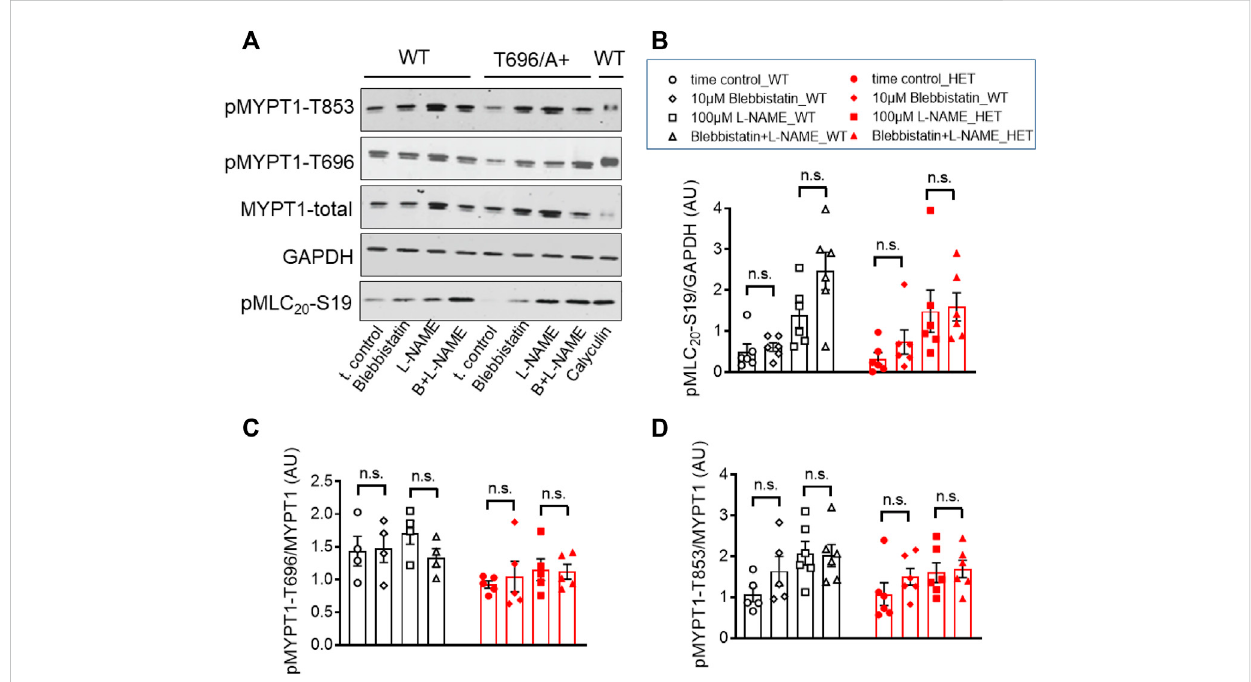
FIGURE 7 Phosphorylation of pMYPT1-T696, pMYPT1-T853, and pMLC 20 -S19 in senescent basilar arteries from WT and MYPT1-T696A/+ mice under inhibition of cross-bridge cycling of non-muscle myosin. (A – D) Original Western blots (A) and statistic evaluation of the phosphorylation of pMLC 20 - S19 (B) , pMYPT1-T696 (C) and pMYPT1-T853 (D) in s-BAs from WT and MYPT1-T696A/+ mice under control conditions and after inhibition of cross- bridge cycling of non-muscle myosin by blebbistatin ( − ). Preparations mounted as previously and treated by vehicle (0.3% DMSO; controls),